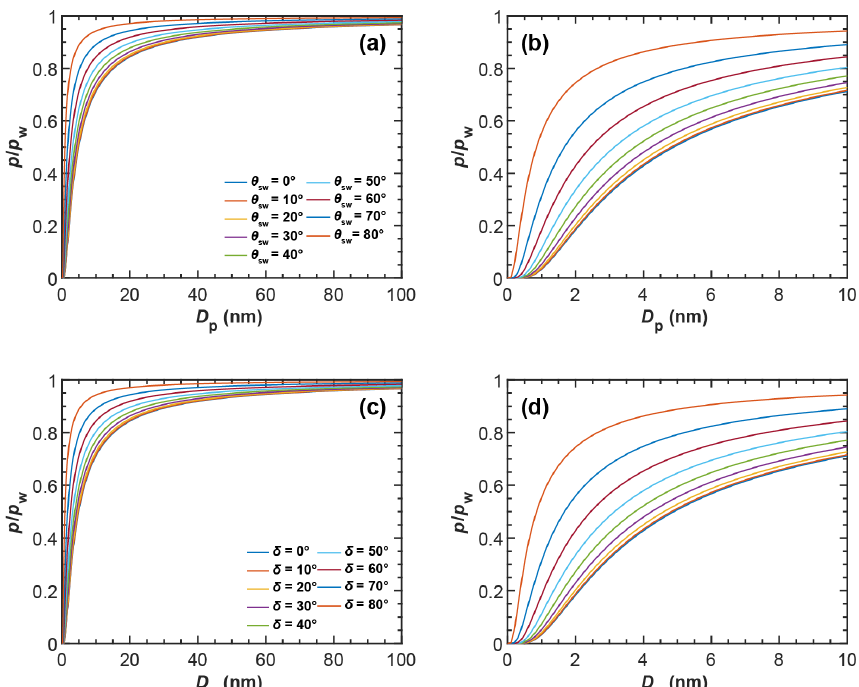
Figure B2. Influence of contact angle and pore opening on pore filling for cylindrical and conical pores. (a, b) Saturation ratio with respect to water ( p/p w ) required to fill cylindrical pores with different water–soot contact angles ( θ sw ), as a function of the pore diameter ( D p ). (c, d) Saturation ratio with respect to water required to fill a conical pore with different opening angles ( δ ) to the level D p , for a fixed value of θ sw = 0 ◦ . Panels (b) and (d) are enlargements of panels (a) and (c) , respectively. All lines are calculated for T = 220K. The relation between the water–soot and ice–soot contact angle is given in Appendix